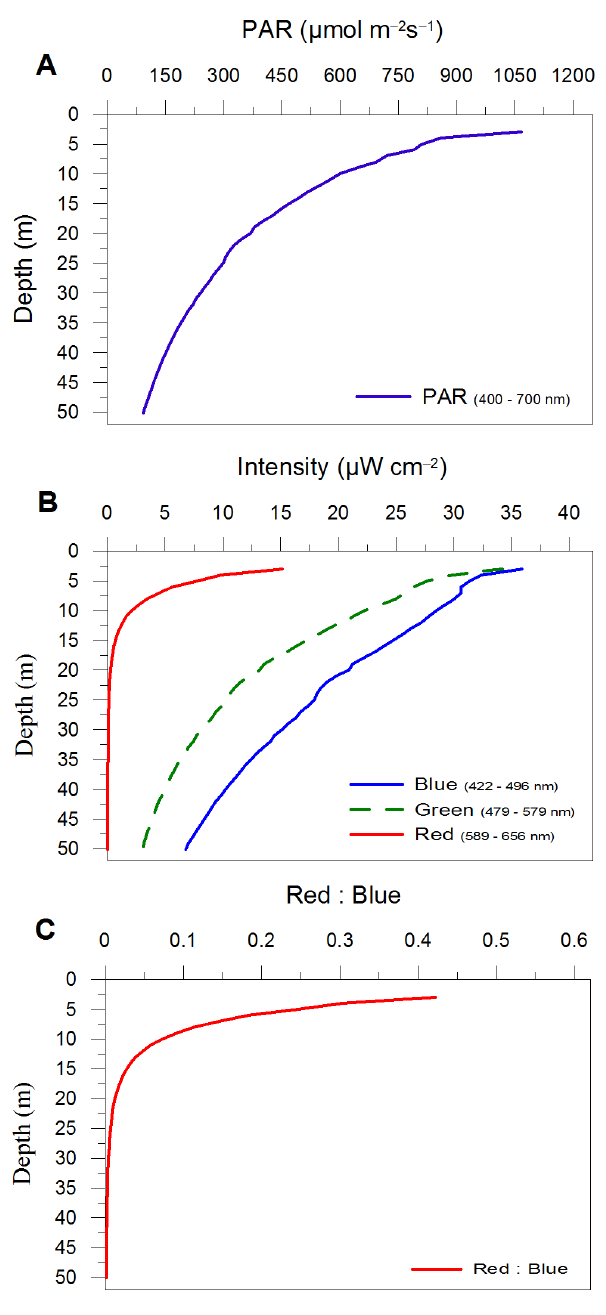
Figure 1. Insitu light profile vs depth. (A) PAR ( m mol photons m – 2 s –1 ) distribution along the water column, (B) blue, red and green radiation distribution along the water column ( m W cm –2 ; blue –422 to 496 nm, green –479 to 579 nm and red –589 to 656 nm), and (C) distribution of red : blue ratio along the water column. Data are mean of profiles done on 5 stations in the Mediterranean Sea in June–July 2008 (C. Brunet, unpublished data).